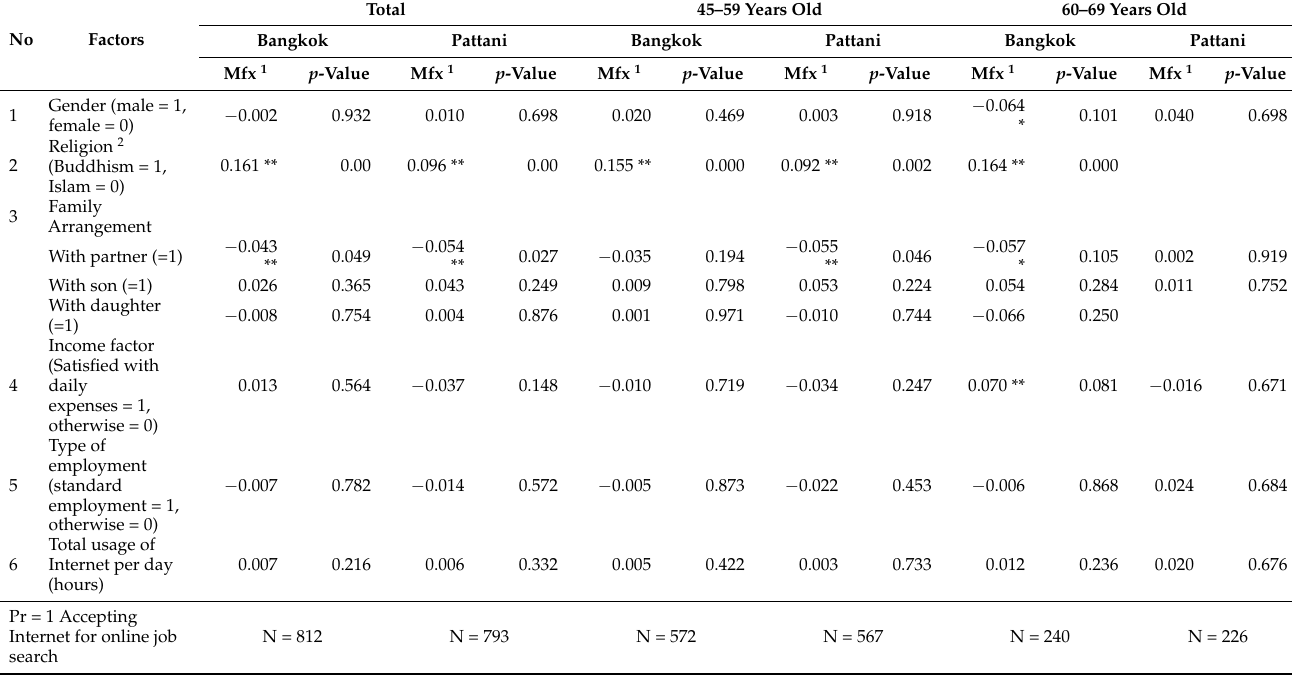
Table 2. Factors influencing probability for accepting Internet for online job